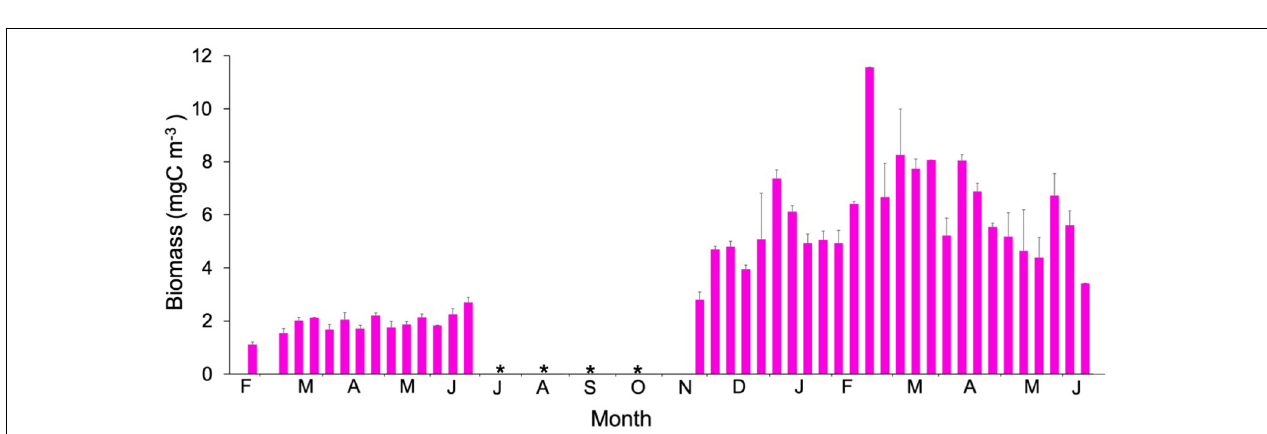
FIGURE 5 | Temporal variability of heterotrophic bacteria biomass ( (cid:4) ). Values are the average of values (mean ± SE) for stations 1, 2, and 3. No data available is represented by an asterisk.